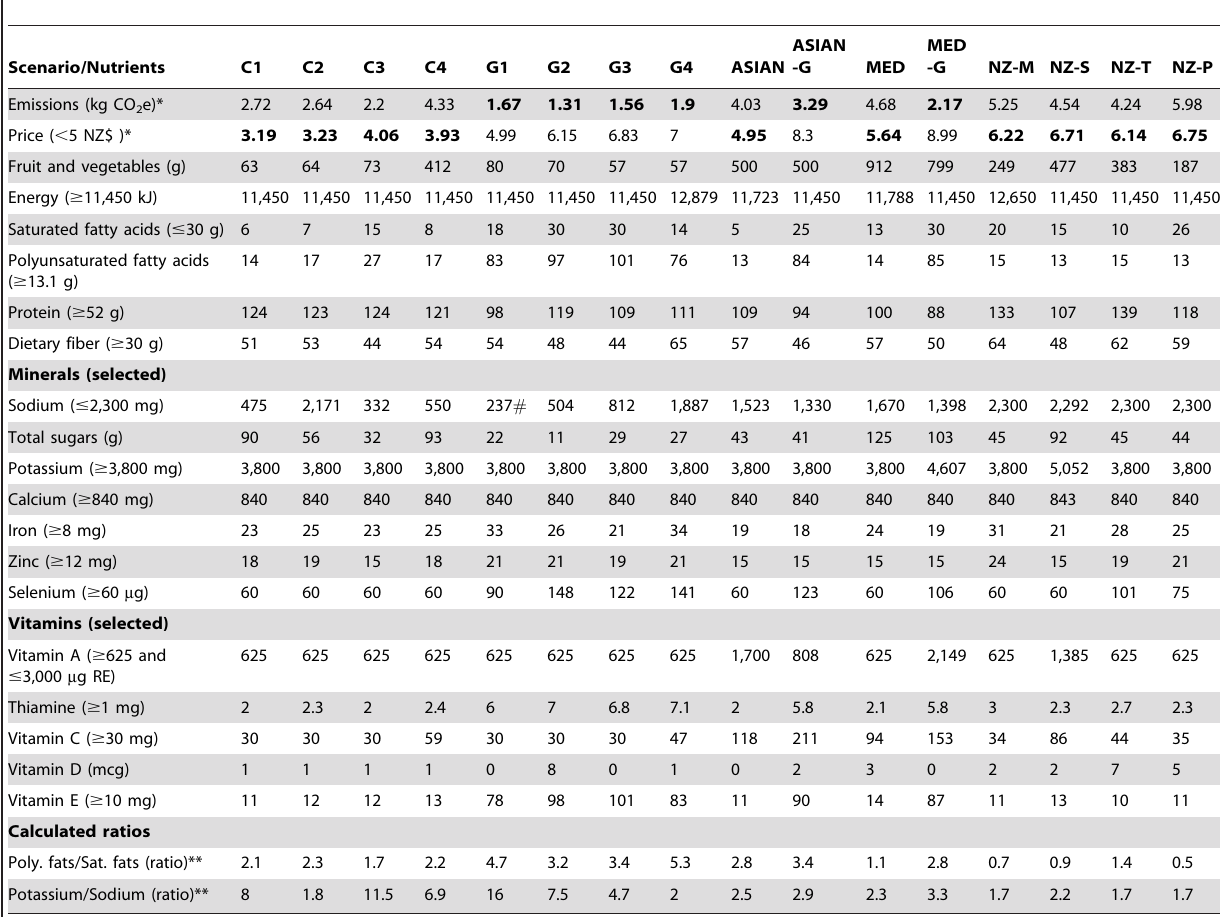
Table 3. Daily costs, emissions of greenhouse gases and nutrient intakes for the different dietary scenarios.